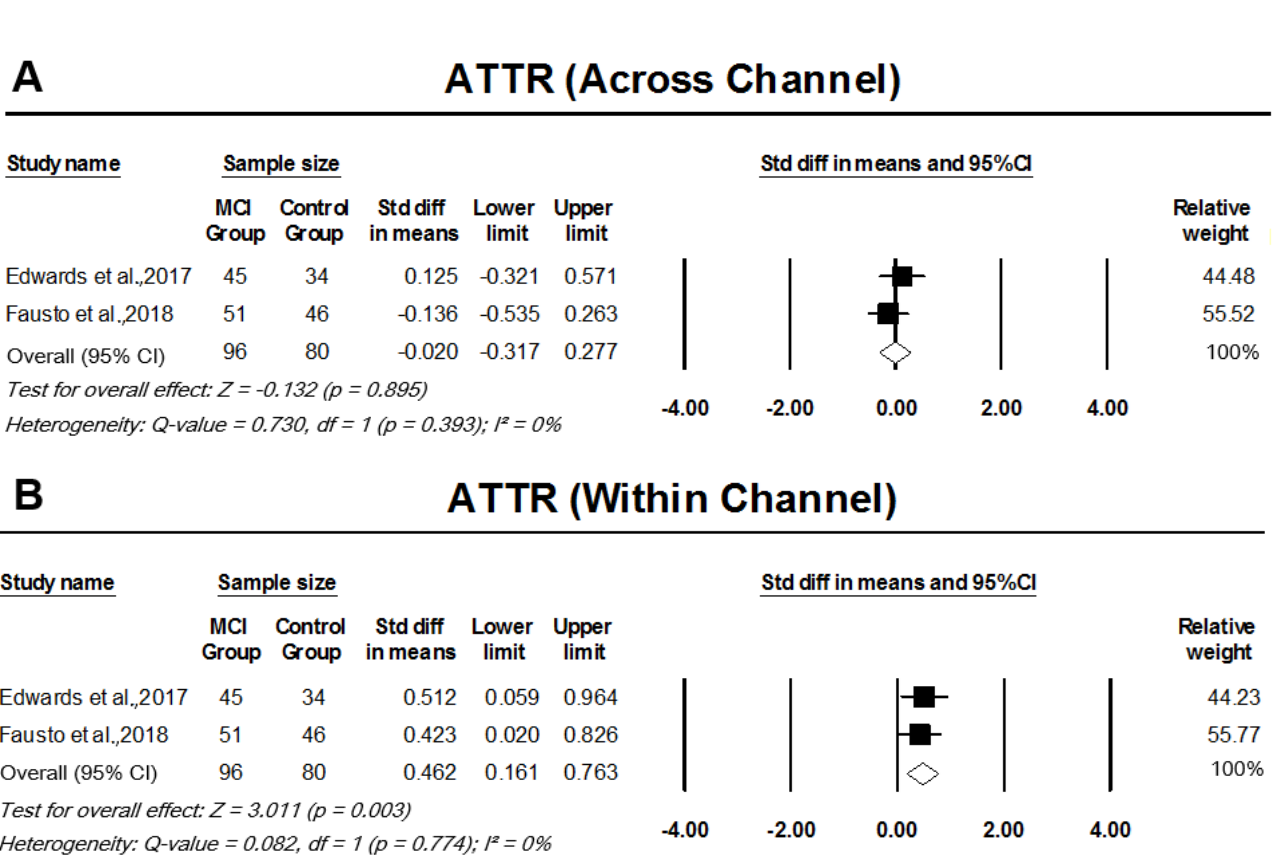
Figure 2. Forest plot of standard mean difference and overall (pooled) estimate of studies investi- gating adaptive tests of temporal resolution (ATTR) that compared a mild cognitive impairment (MCI) group to a control group. ( A ) Analysis of within-channel ATTR, ( B ) analysis of across-channel ATTR. Notes: Z= Z score; I 2 = percentage of heterogeneity; Q-value = Cochrane’s Q; df = degrees of freedom. The horizontal lines represent the 95% confidence interval (CI) for each computed standard mean difference. Weights are from the random-effects analysis.